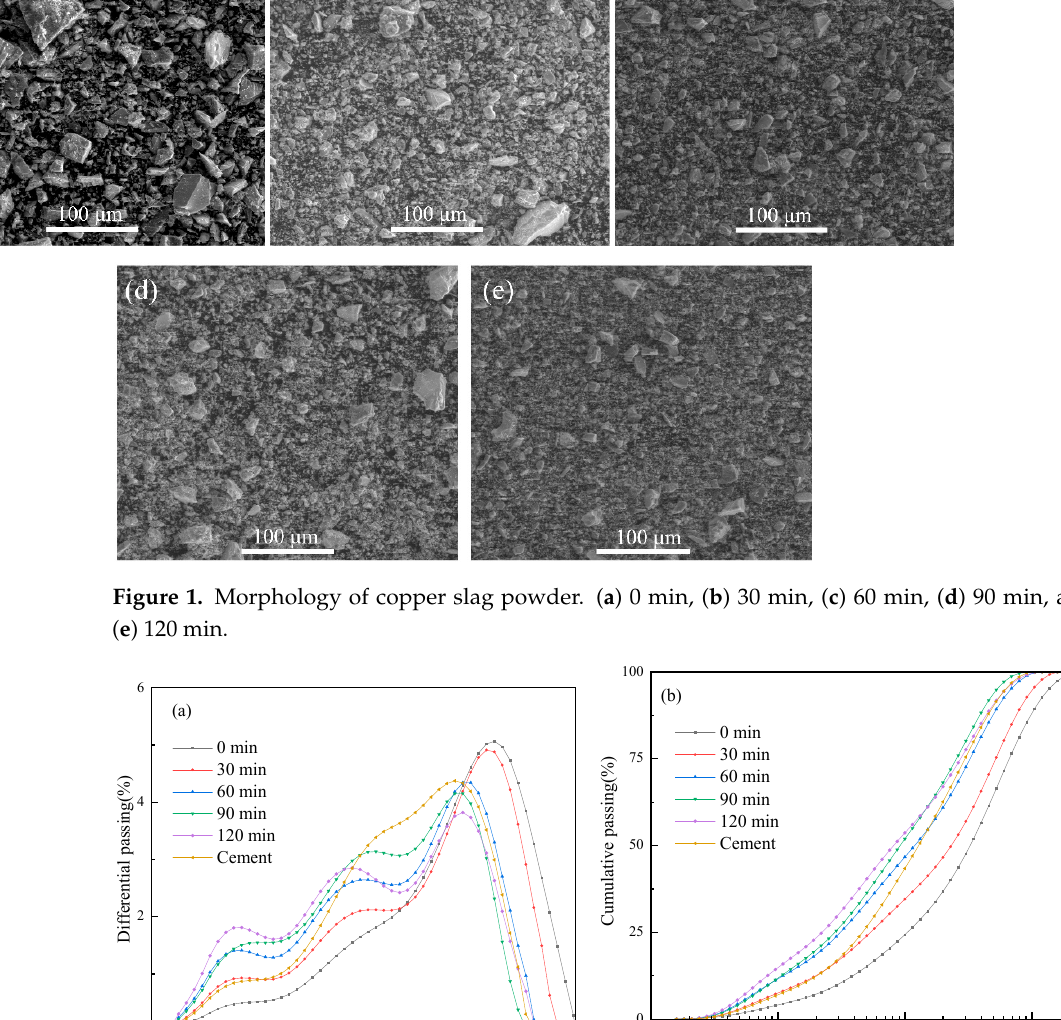
Figure 1. Morphology of copper slag powder. ( a ) 0 min, ( b ) 30 min, ( c ) 60 min, ( d ) 90 min, and ( e ) 120 min.